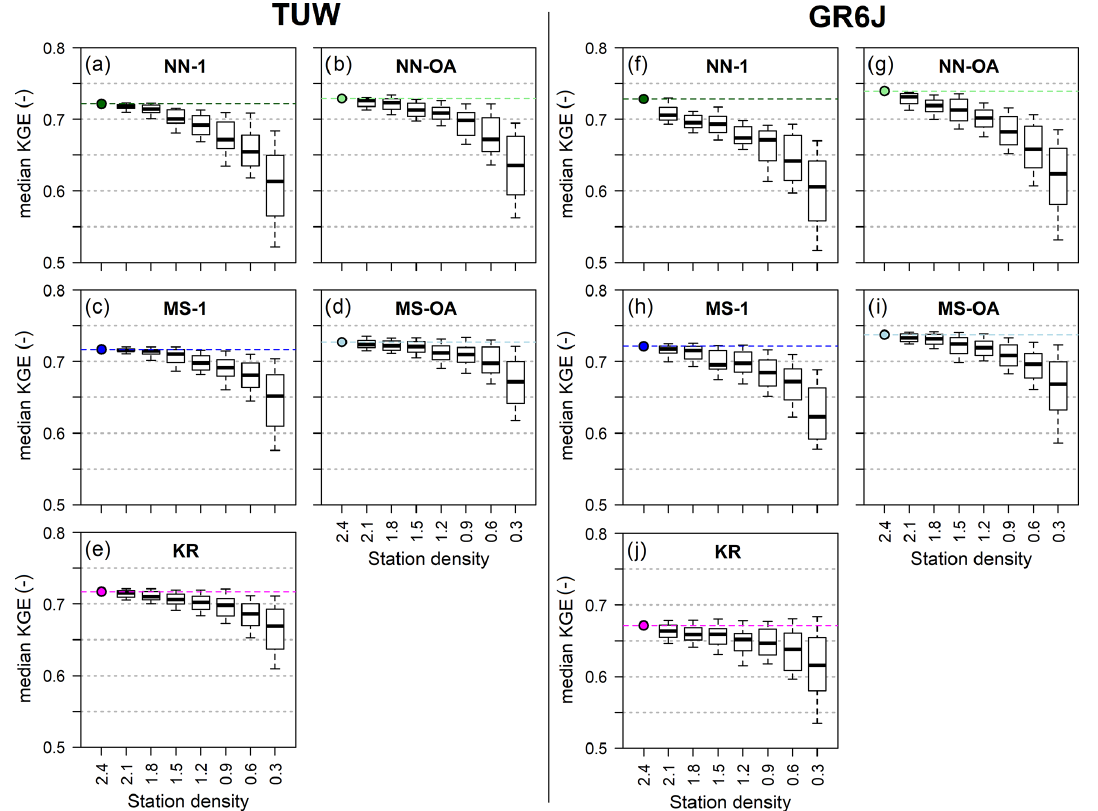
Figure 12. Median Kling–Gupta efficiency of the 100 sampled datasets for varying station density (number of gauges per 1000km 2 ) for the TUW and GR6J models using the NN-1 (a, f) , NN-OA (b, g) , MS-1 (c, h) , MS-OA (d, i) and KR (e, j) regionalisation methods. The coloured point and dotted line in the plots indicate the original median regionalisation efficiency of the approaches when using all available donors (i.e. full station density, corresponding to 2.4 gauges per 1000km 2